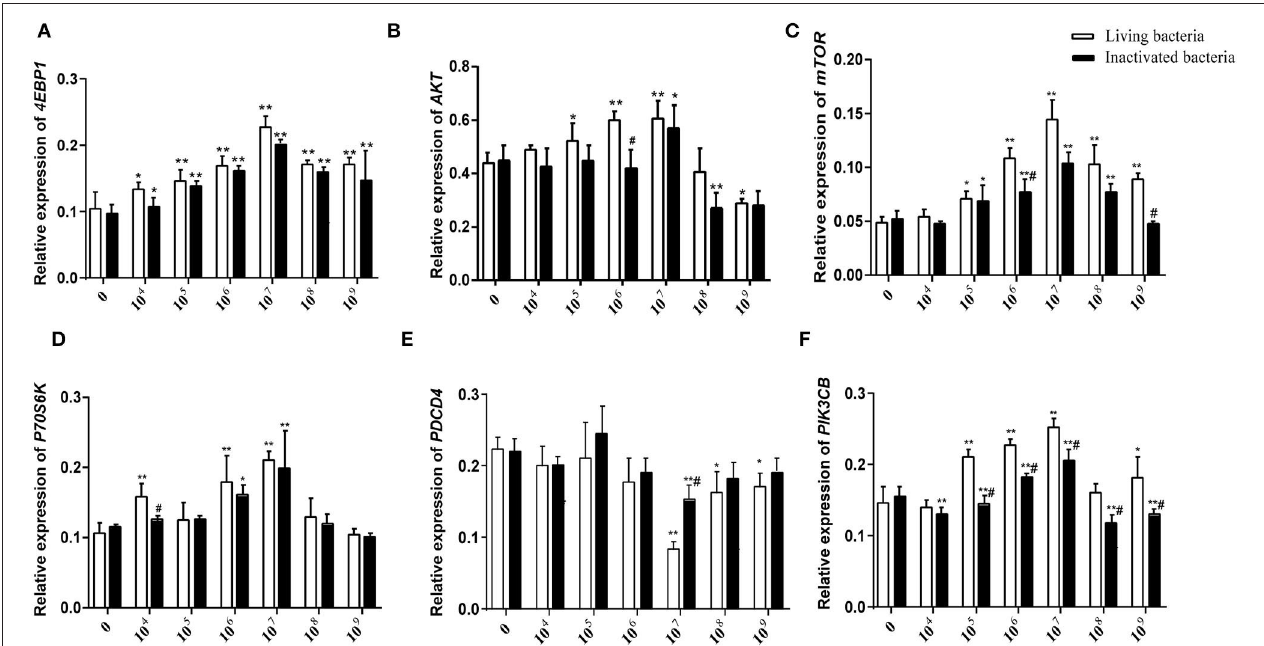
FIGURE 6 | Effects of different concentrations of living IIIVE-4 bacteria on gene expression of key factors in the PIK3CB-AKT-mTORC1 pathway in rumen explants ( n = 9). The expression of 4EBP1 (A) , AKT (B) , mTOR4 (C) , P70S6K (D) , and PI3K (F) genes was highest when adding living IIIVE-4 bacteria at a concentration of 10 7 , while PDCD (E) gene expression was lowest when the bacterial concentration was 10 7 . One-way ANOVA in SPSS 22.0 software was used to analyze the data, presented as mean ± sd. The ratio of all gene expression levels compared to the housekeeping gene β -actin was obtained as the relative expression of the gene. *Indicates significant difference from control group within the same group ( p < 0.05). # Indicates significant difference compared to other groups at the same time or the same concentration gradient ( p < 0.05). **Indicates highly significant difference ( P <